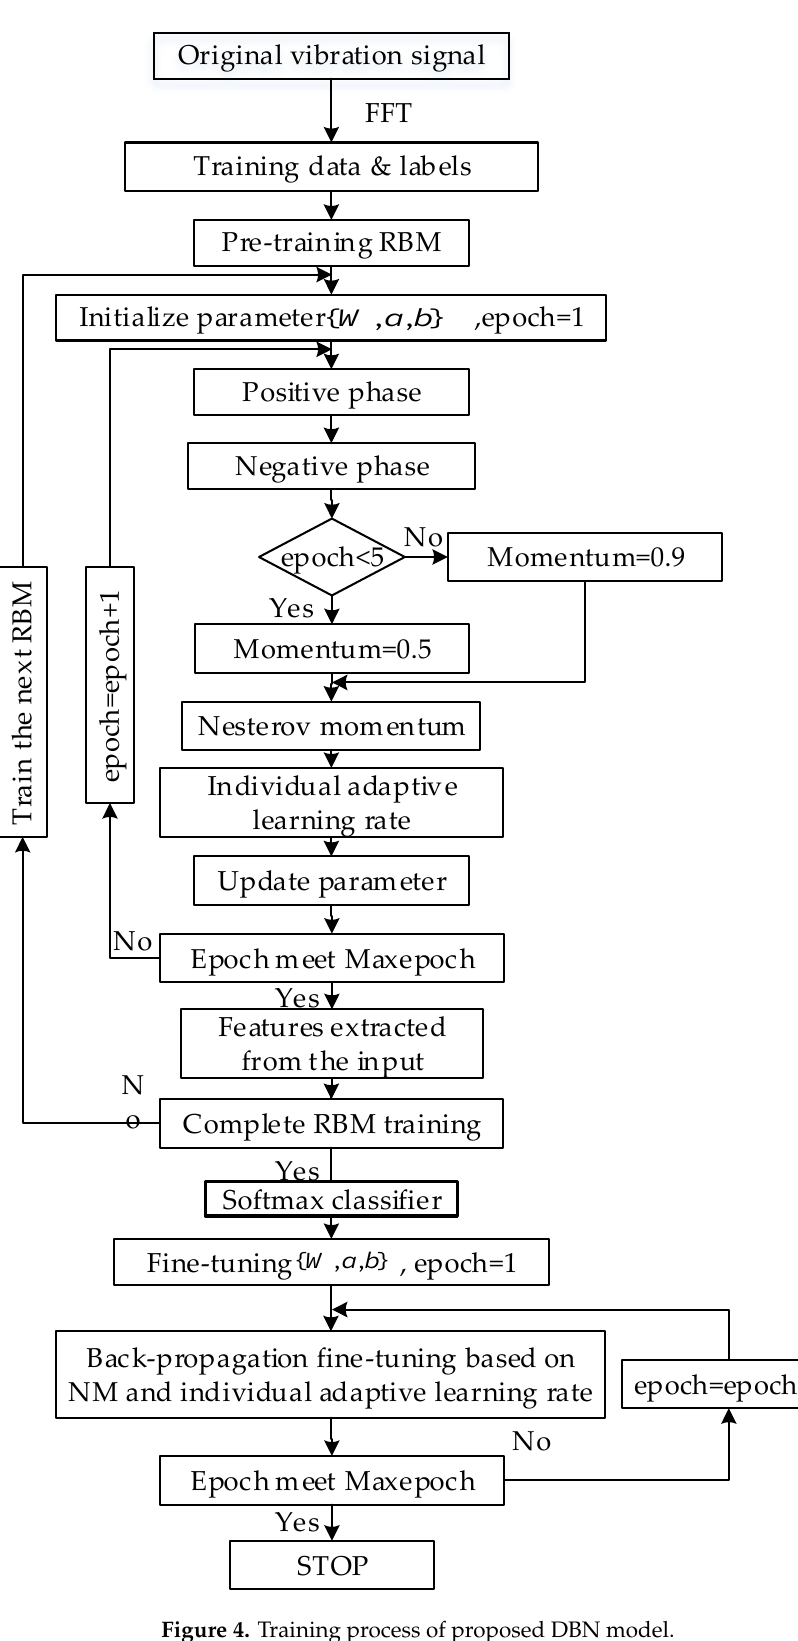
Figure 4. Training process of proposed DBN model. Table 2. Description of dataset for hierarchical fault diagnosis model.